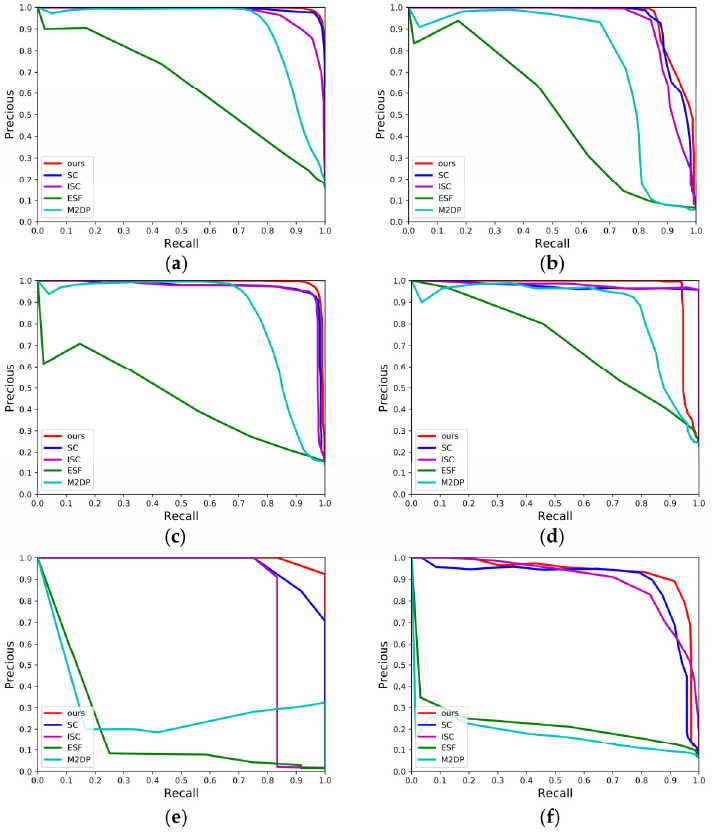
Figure 15. P -R curves of different methods over the dataset KITTI. ( a ) KITTI-00; ( b ) KITTI-02; ( c ) KITTI-05; ( d ) KITTI-06; ( e ) KITTI-07; ( f ) KITTI-08.